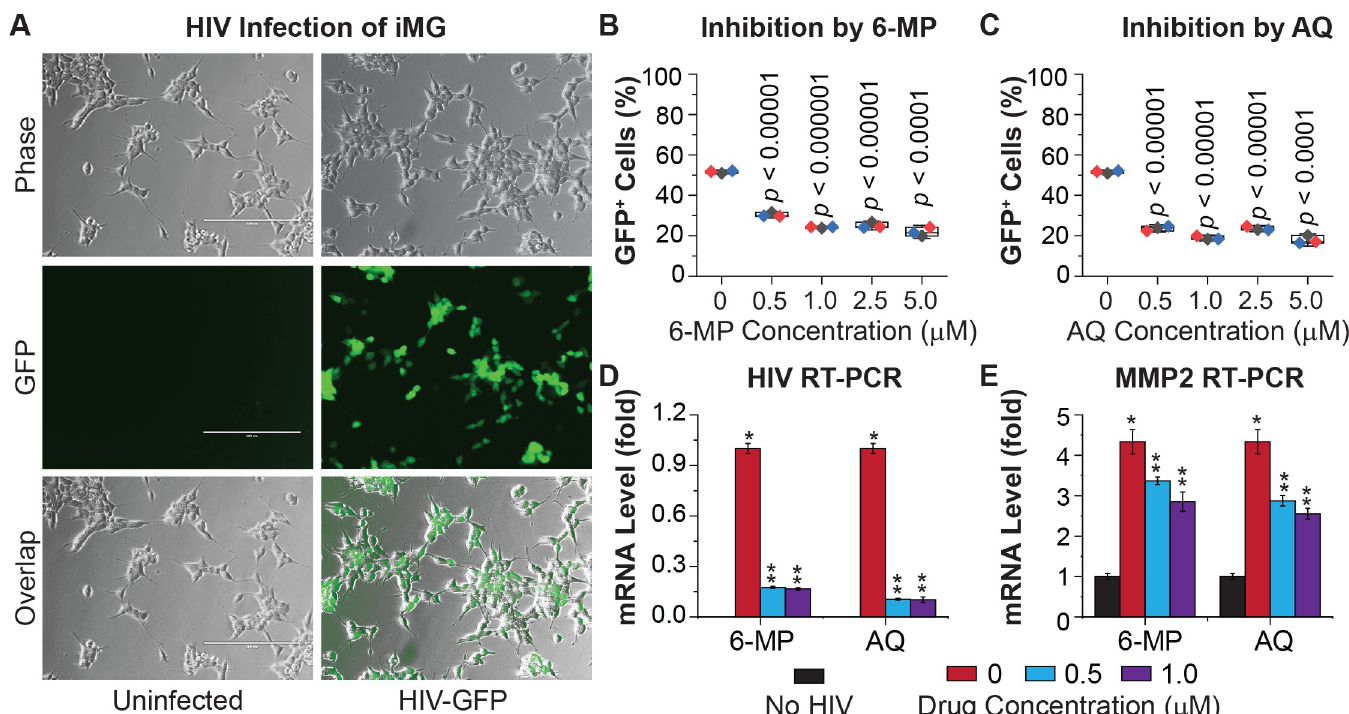
Fig 11. Nurr1 Mediates HIV silencing in iPSC-derived microglial cells (iMG). A, Representative phase contrast, GFP, and overlapped images of iMG that were un- infected or infected with the reporter HIV-1 shown in Fig 1A, at 48 hr post-infection (hpi). HIV-infected iMG were treated with different doses of Nurr1 agonist 6-MP or AQ for four days, followed by flow cytometry analysis of GFP expression. B, The average levels of GFP expression in iMG treated with various doses of 6-MP were calculated from three replicates. C, The average levels of GFP expression in iMG treated with various doses of AQ were calculated from three replicates. D, The average levels of HIV RNA (un-spliced) in the cells described in panels A and B , were measured by RT-qPCR and calculated from three replicates of qRT-PCR. The mean value of HIV transcript from HIV infected but untreated cells was referred to as level “1”. E, The mRNA level of Nurr1 target gene MMP2 in the same cells described in D was measured by qRT-PCR. The mean value of MMP2 mRNA from three replicates of un-infected cells was referred to as level “1”. The average levels of HIV transcript and MMP2 mRNA in each sample were calculated from three technical replicates. Differences in HIV and MMP2 mRNA levels between untreated cells and cells treated with different doses of 6-MP or AQ were statistically significant ( �� p -values < 0.001). HIV transcripts were only detected in infected iMG cells (panel D ). MMP2 mRNA was significantly elevated in HIV infected iMG (panel E ).